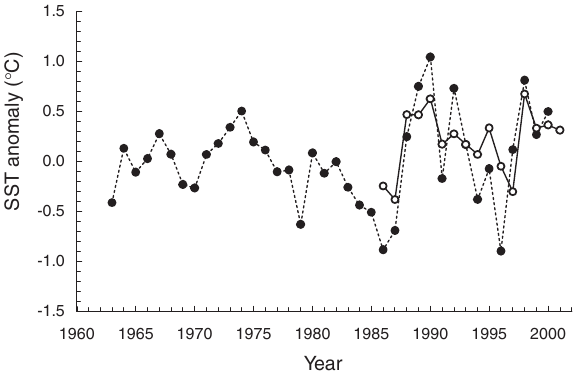
F IG . 1. – Comparison of observed (dotted line) and forecast (plain line) sea surface temperature anomalies for the North Sea. The geo- graphic area covered is 2.5°W-10°E and 50.0°N-62.5°N. The observed anomalies are from the NCEP/NCAR re-analysis dataset and are averaged over the period February to June. Forecasts are given with 0-month lead (at the end of